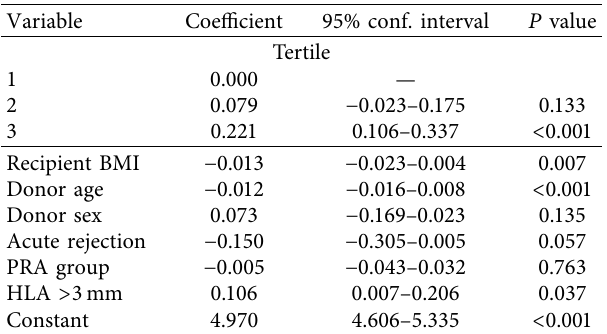
Figure 6: Recipient eGFR and donor kidney volume by tertile at 1 year after transplant. Table 3: Multivariable model for the effect of donor volume tertiles on 1-year recipient